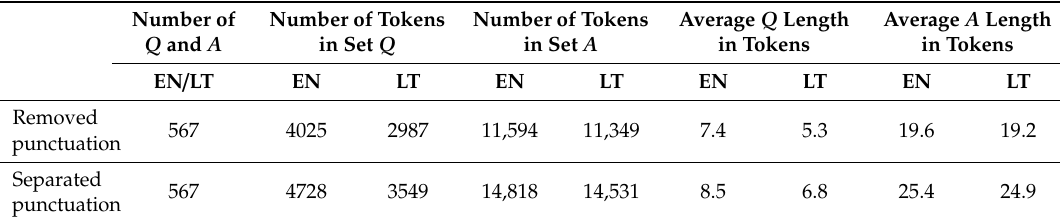
Table 1. English (EN) and Lithuanian (LT) datasets used in generative chatbots (Q and A abbreviations stand for questions and answers,